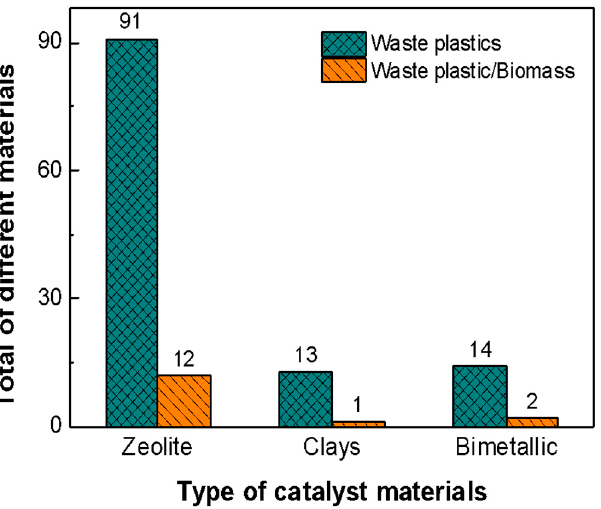
Figure 1. Popularity of different types of catalytic materials for pyrolysis of plastic waste from 2015 to 2020. (Source: Web of Knowledge, https://www.webofknowledge.com, accessed on 1 April 2020).